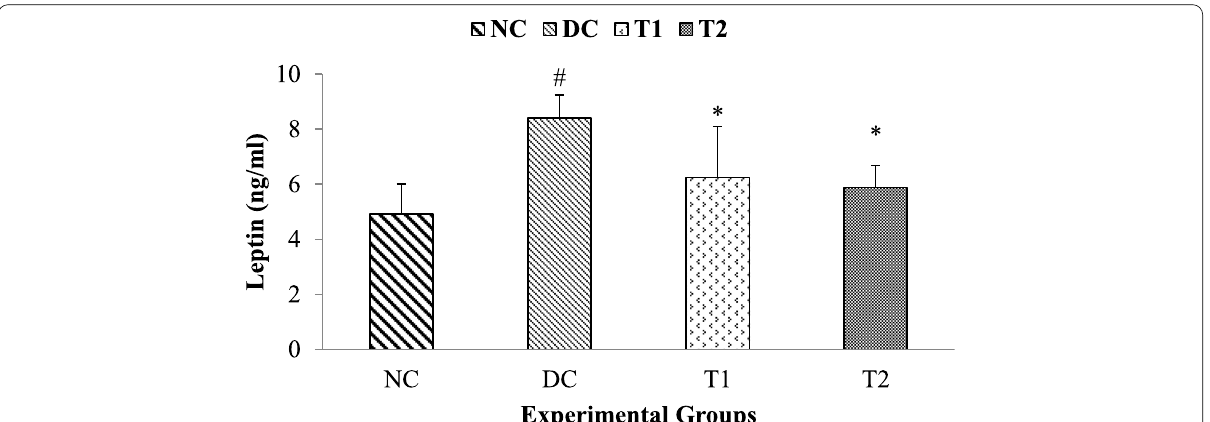
Fig. 5 Effect of probiotic fermented milk products on serum leptin level . (NC with WPC and SPI, T2 probiotic fermented milk without WPC and SPI) Statistical analysis was performed by applying one-way ANOVA followed = by Dunnet’s Test using Graph Pad Prism V6.0. Statistical significance was kept at P < 0.05 and P < 0.01. #-Indicate significant difference from Normal control group. *-Indicate significant difference from Disease control